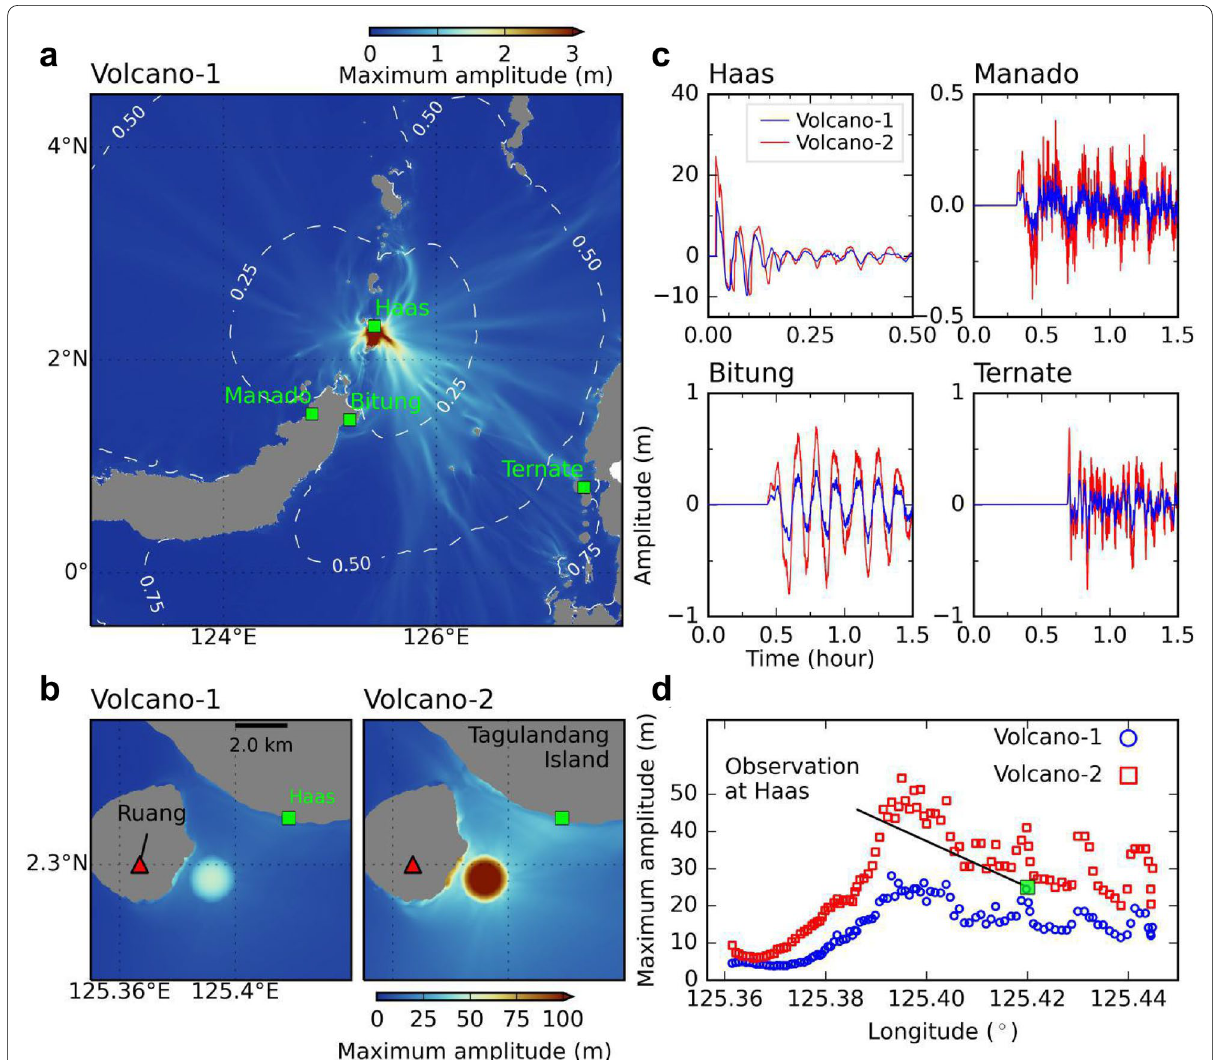
Fig. 8 Simulated tsunami heights from the 1871 Ruang Volcano eruption in the Molucca Sea, eastern Indonesia. a Maximum tsunami amplitude from Volcano-1 scenario with dashed white contours showing the tsunami travel times in hour. b Maximum tsunami amplitudes from Volcano-1 and Volcano-2 scenarios in the finest grid domain. c Tsunami waveforms at four locations shown in ( a ) and ( b ). d Maximum coastal tsunami amplitudes at along south coast of Tagulandang Island to validate the 1871 observation